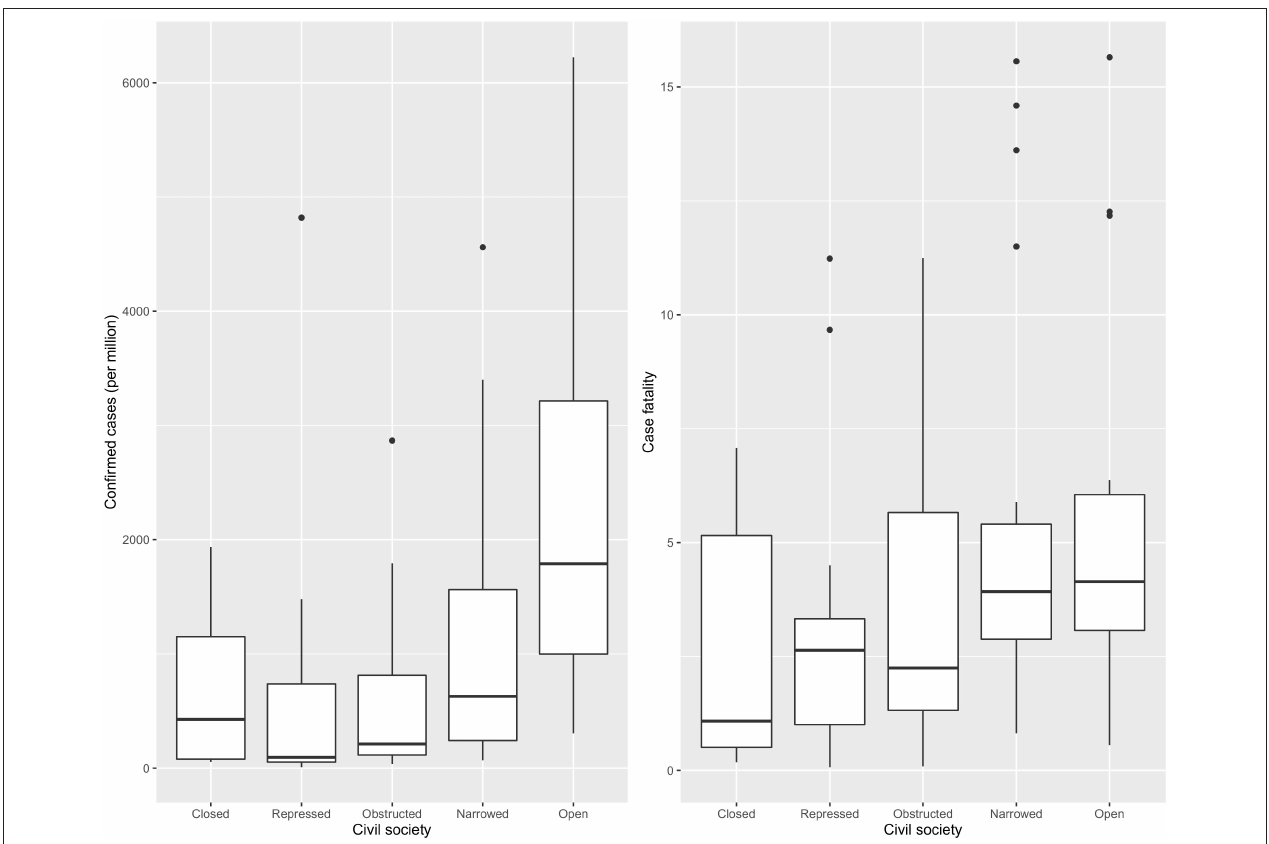
FIGURE 1 | Civil society wise distribution of the number of cases per million and case